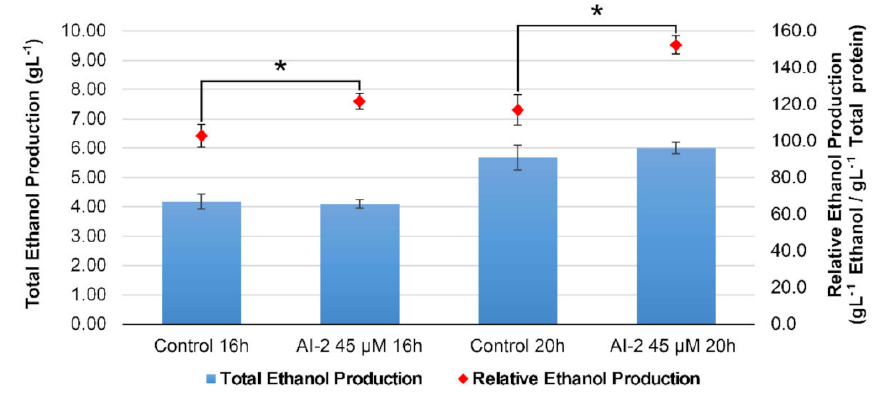
Figure 6. Ethanol production by Z. mobilis in response to AI-2. Cultures of Z. mobilis were established, as described in Figure 1 and grown for 14 h, until they reached mid exponential growth phase. At this time, AI-2 was added, at 45 µ M final concentration, and the cultures were further incubated for additional six hours, until they all reached stationary growth phase. Aliquots (2 mL) were collected at times t = 16 h and t = 20 h for ethanol quantification, using the EnzyChrom ® Ethanol Assay kit, and to quantify total protein accumulated in the bacterial biomass, at these different timepoints (see Materials and Methods for details). Blue bars display the absolute ethanol concentration in each sample (left axis), while the red dots display their relative ethanol production, normalized by biomass accumulation (right axis). The graph shows the average results and their respective SEMs, obtained from three independent experiments. * represents statistically significant differences in relation to the respective controls (AI-2 untreated cultures), after a two-tailed t -test, using p < 0.05 as a